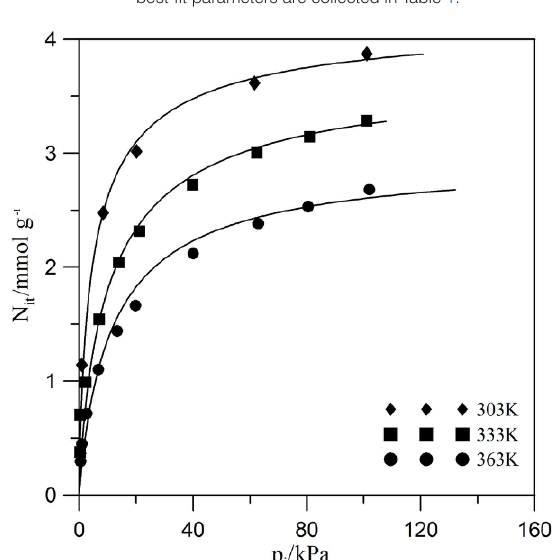
Figure 1. The fits of the experimental equilibrium isotherms of C H adsorption on the Norit activated carbon reported 2 6 by Qiao and Hu [14]. The solid lines are the theoretical isotherms calculated by Eq. 5. The values of the obtained best-fit parameters are collected in Table 1.